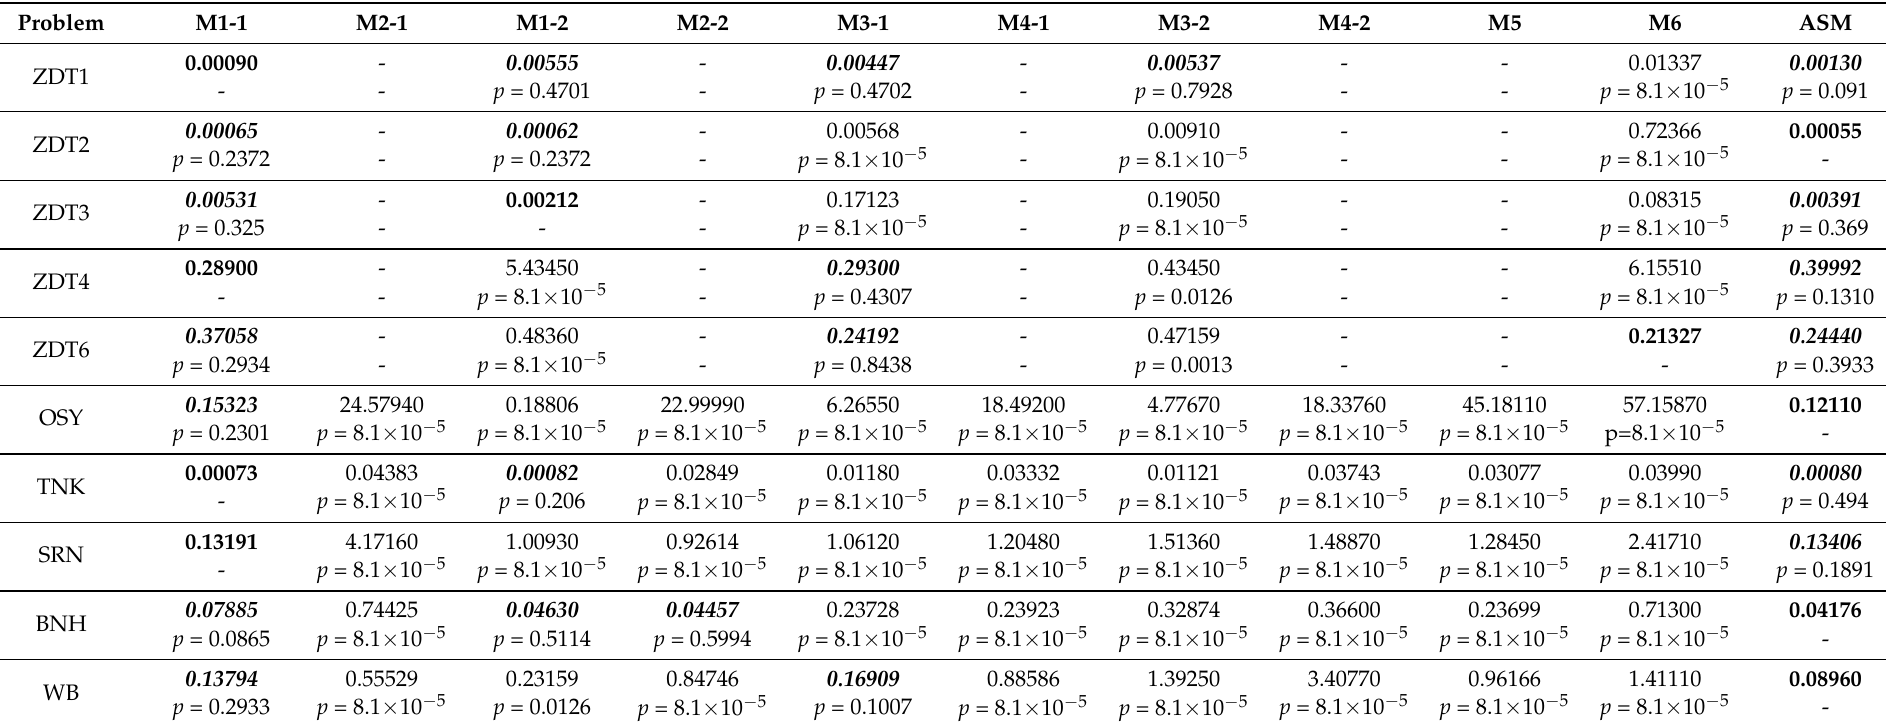
Table 3. IGD values obtained from all the individual frameworks and proposed switching algorithm on different test problems are presented. The best performing framework and other statistically similar frameworks are marked in bold with their p -values in the second row. For problems without any constraint, the framework M i -1 is identical to M i -2, hence a “-” is provided for the latter. For unconstrained problems, M5 and M6 are also